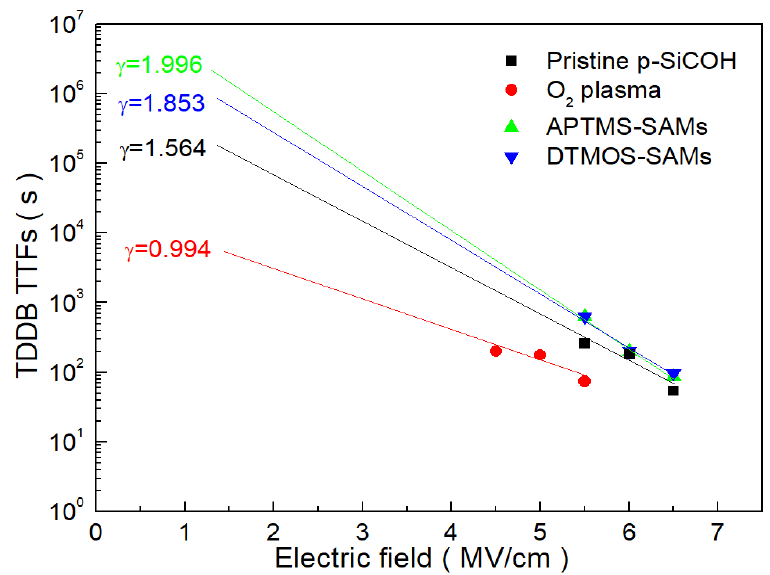
Figure 6. TDDB TTFs of pristine, O 2 plasma-irradiated, APTMS-SAMs, and DTMOS-SAMs p-SiOCH films as a function of the stressing electric field.